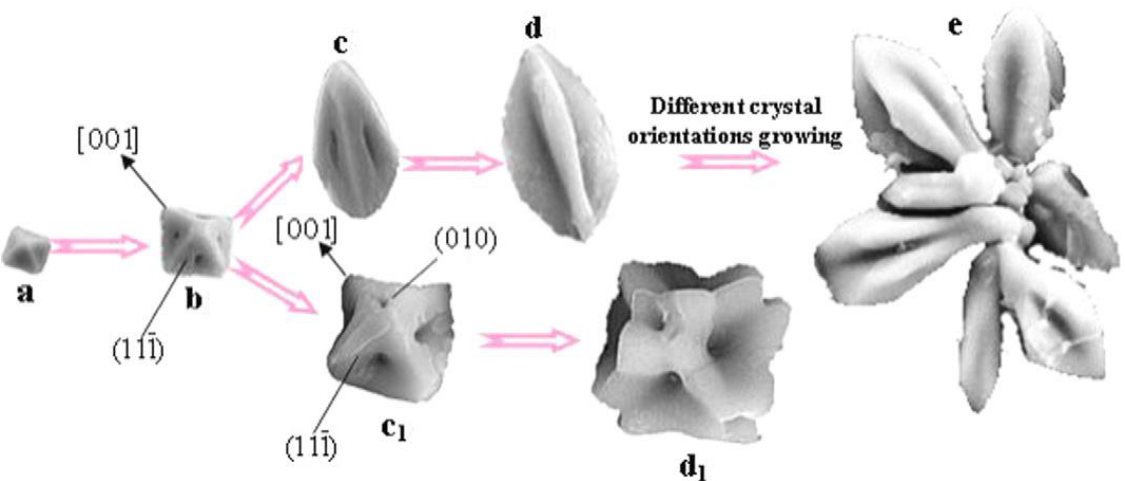
Figure 6: The mechanism of NbC growth [32]